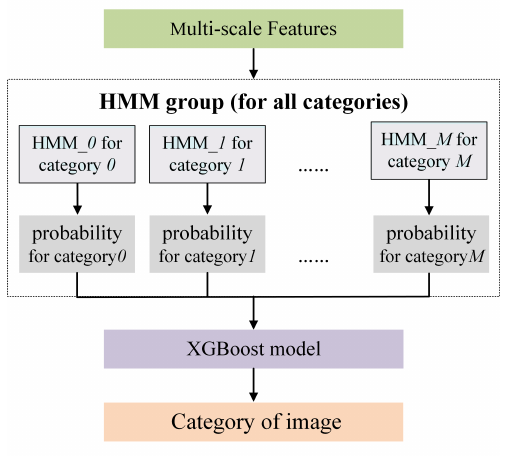
Figure 9. The process of the stacking ensemble